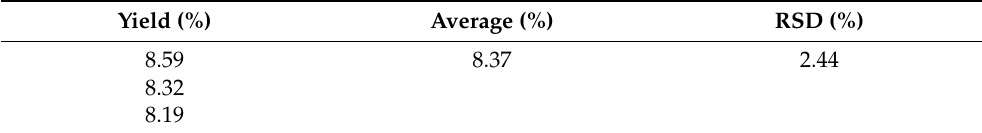
Table 3. Process verification results.